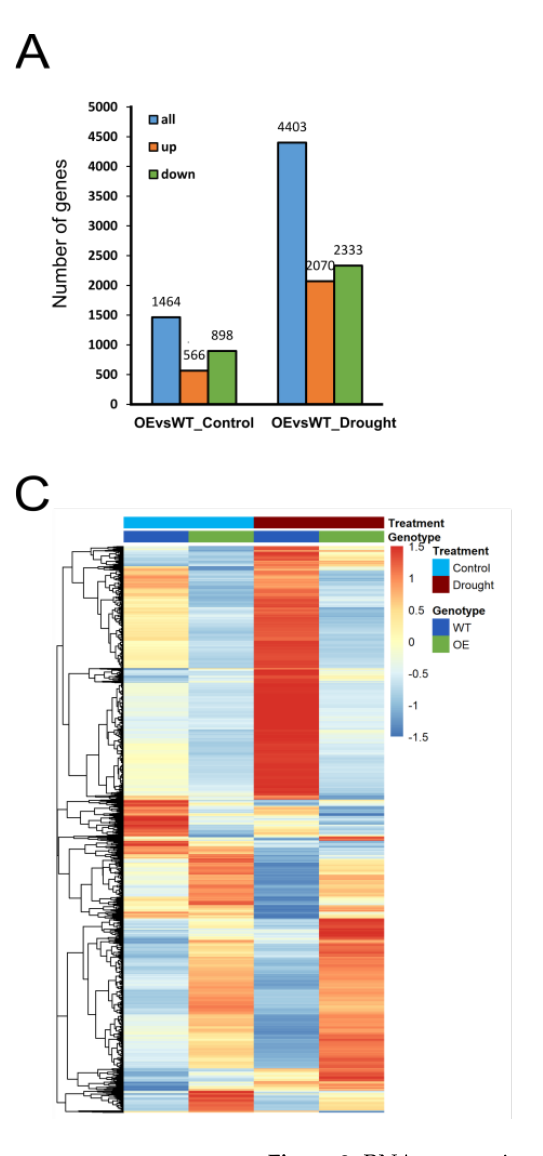
Figure 3. RNA sequencing of primary leaves at 28 das from WT and oeW1-2 grown in control and drought conditions. ( A ) The numbers of differentially expressed genes (DEGs). ( B ) Volcano plots showing distribution of differentially up- and down-regulated genes under control and drought conditions. ( C ) Z-score heatmap of DEGs generated from FPKM value. ( D ) Expression of ABA biosynthesis-related genes. The heatmap was generated from the RNA sequencing data with manual curation. The bars in ( C , D ) show color codes for the heatmap Z-score scale.